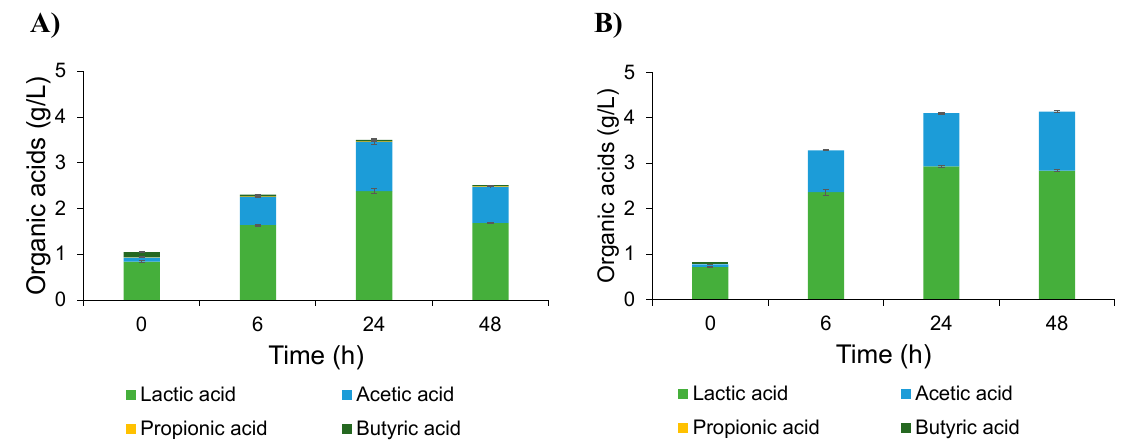
Figure 5. Lactic acid and SCFAs profiles of inulin-FOS extract fermentation ( A ) compared with those of glucose fermentation ( B ).